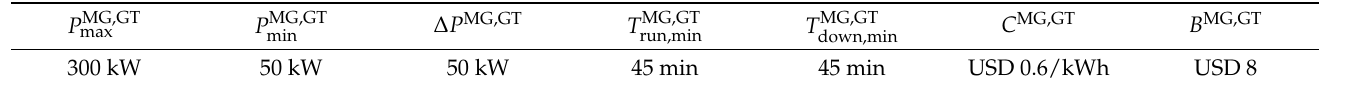
Table A2. Parameters of gas turbine (MG).